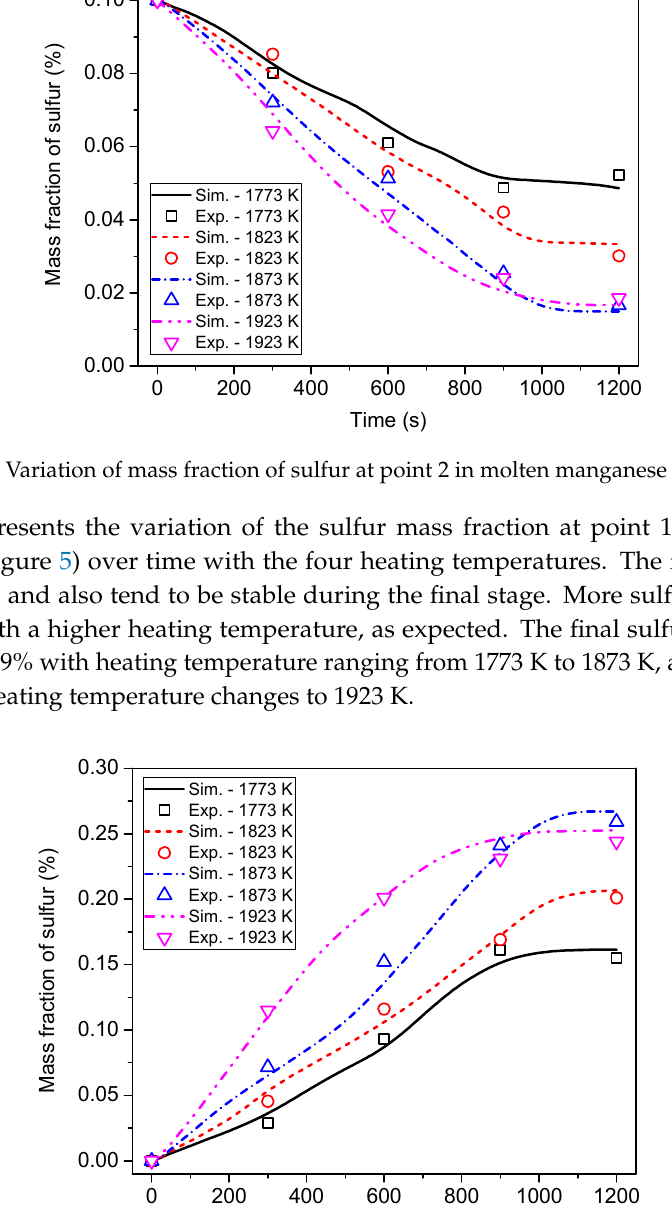
Figure 10. Variation of mass fraction of sulfur at point 1 in molten slag over time.